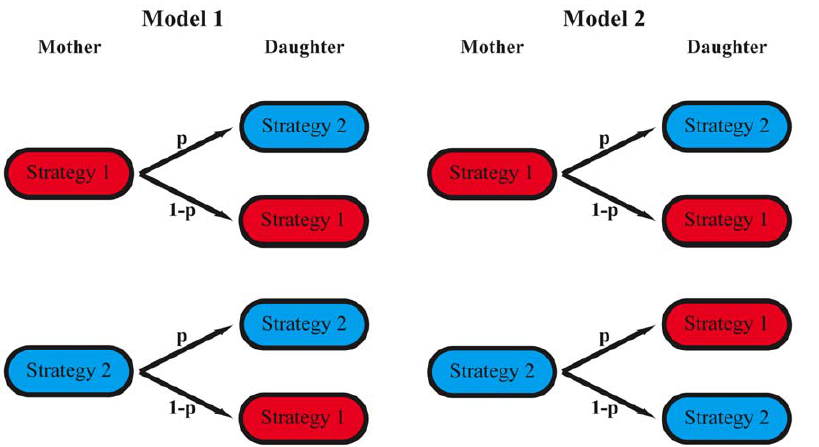
Figure 4. Division scheme in the two models for phenotypic diversification. A newborn cell randomly chooses a growth strategy. In model 1, strategy 2 is chosen with probability p , strategy 1 with probability 1 { p independent of the strategy of the mother cell. In model 2 this scheme is different, since here the probability of having strategy 1 or 2 depends on the strategy of the mother cell. Here, p denotes the probability that a newborn cell has a different strategy than its mother cell.